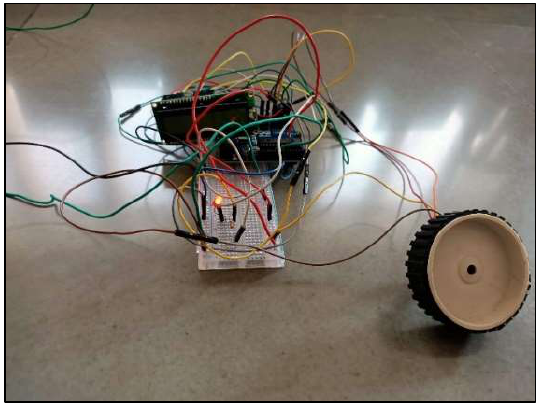
Fig. 12. Path Processing